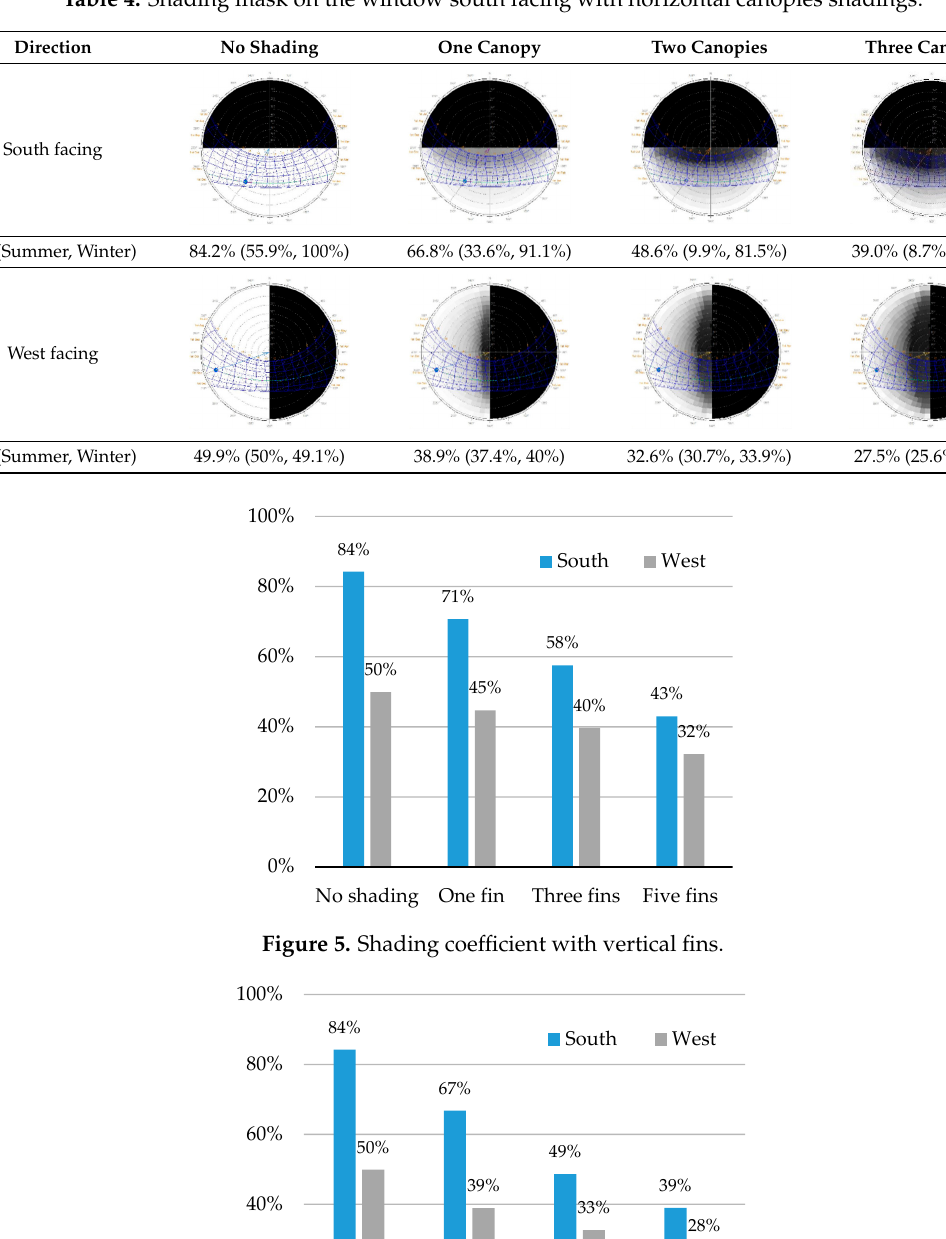
Figure 6 . Shading coefficient with horizon canopy.